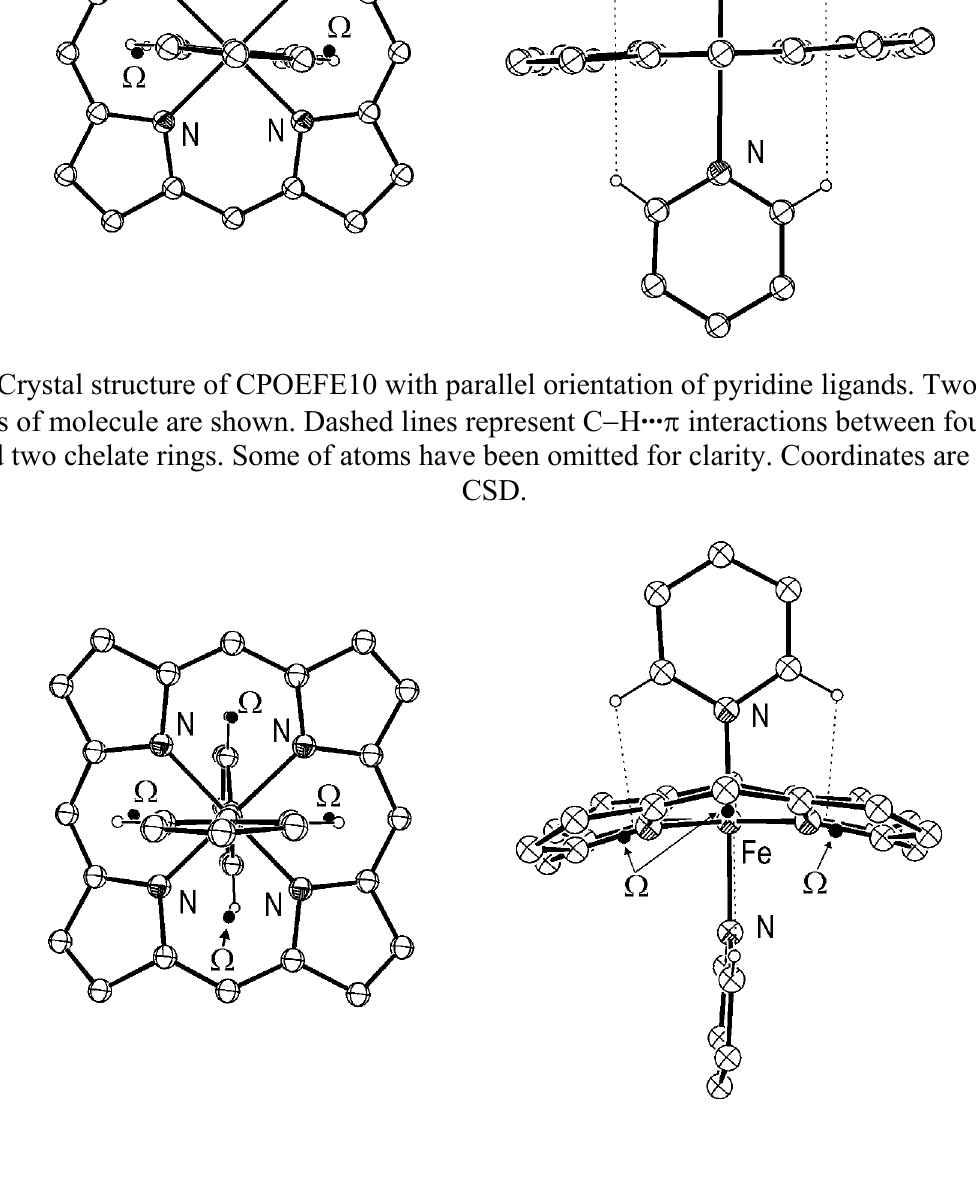
Figure 7. Crystal structure of KEFFOG with orthogonal orientation of pyridine ligands. Two orthogonal projections of molecule are shown. Dashed lines represent C − H ··· π interactions between four hydrogen atoms and four chelate rings. Some of atoms have been omitted for clarity. Coordinates are taken from